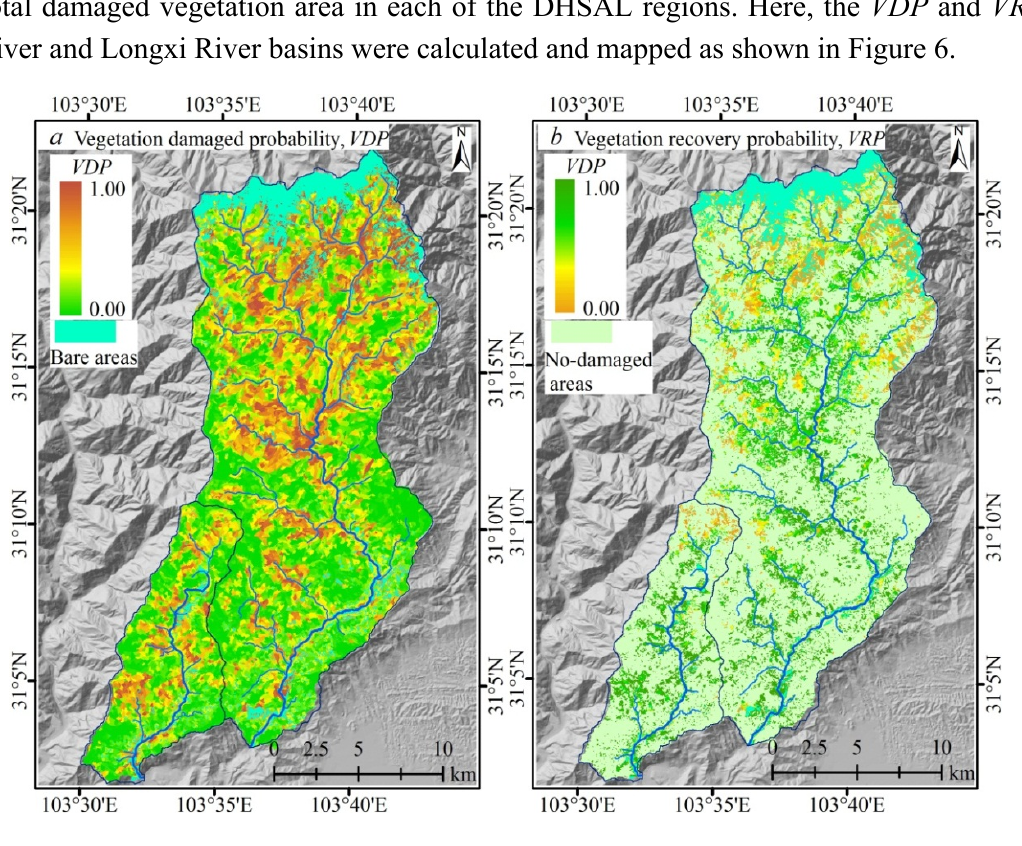
Figure 6. ( a ) Vegetation damaged probability, VDP map of the study area; ( b ) vegetation recovery probability, VRP map of the study